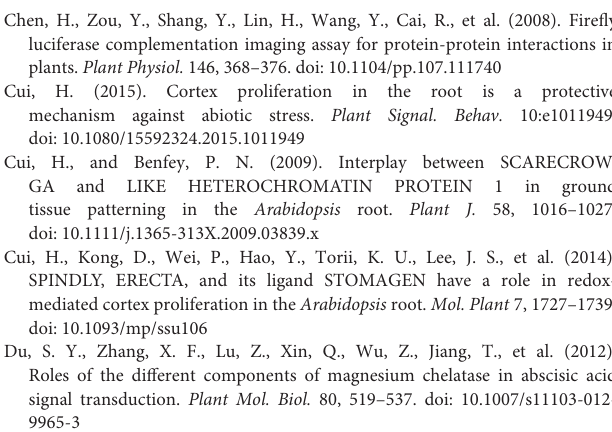
Supplementary Figure 2 | Purification of GFP-tagged CPN20 and CPN10 α 1 by immuno-precipitation from 293T cells. Supplementary Figure 3 | GFP-tagged CPN20 purified from germinating seeds of CPN20-GFP-overexpressing plant. Supplementary Figure 4 | CPN20 peptide is O-fucosylated in an in vitro SPY activity assay. Supplementary Figure 5 | CPN20-GFP localization in chloroplasts of cotyledon mesophyll and guard cells of 30-day-old seedlings. Supplementary Figure 6 | cpn20-1 suppresses insensitivity of spy-3 to ABA. Supplementary Figure 7 | SPY is absent in the chloroplast. Supplementary Table 1 | Primers used in this